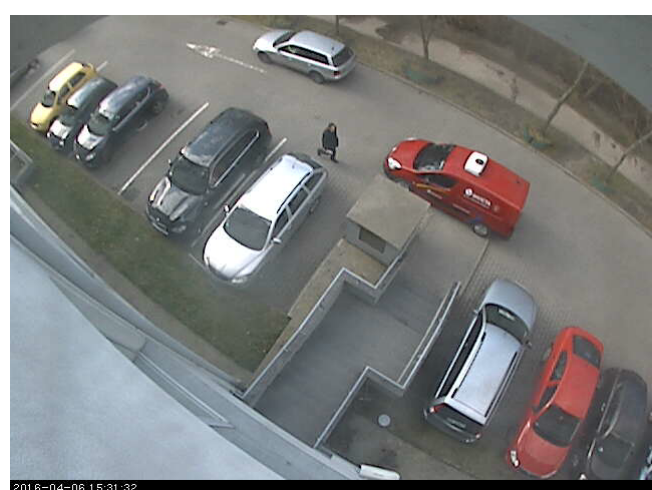
Figure 6. Field of vision of Camera b used in the